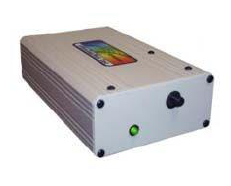
Figure 2. Spectroradiometer EPP2000.